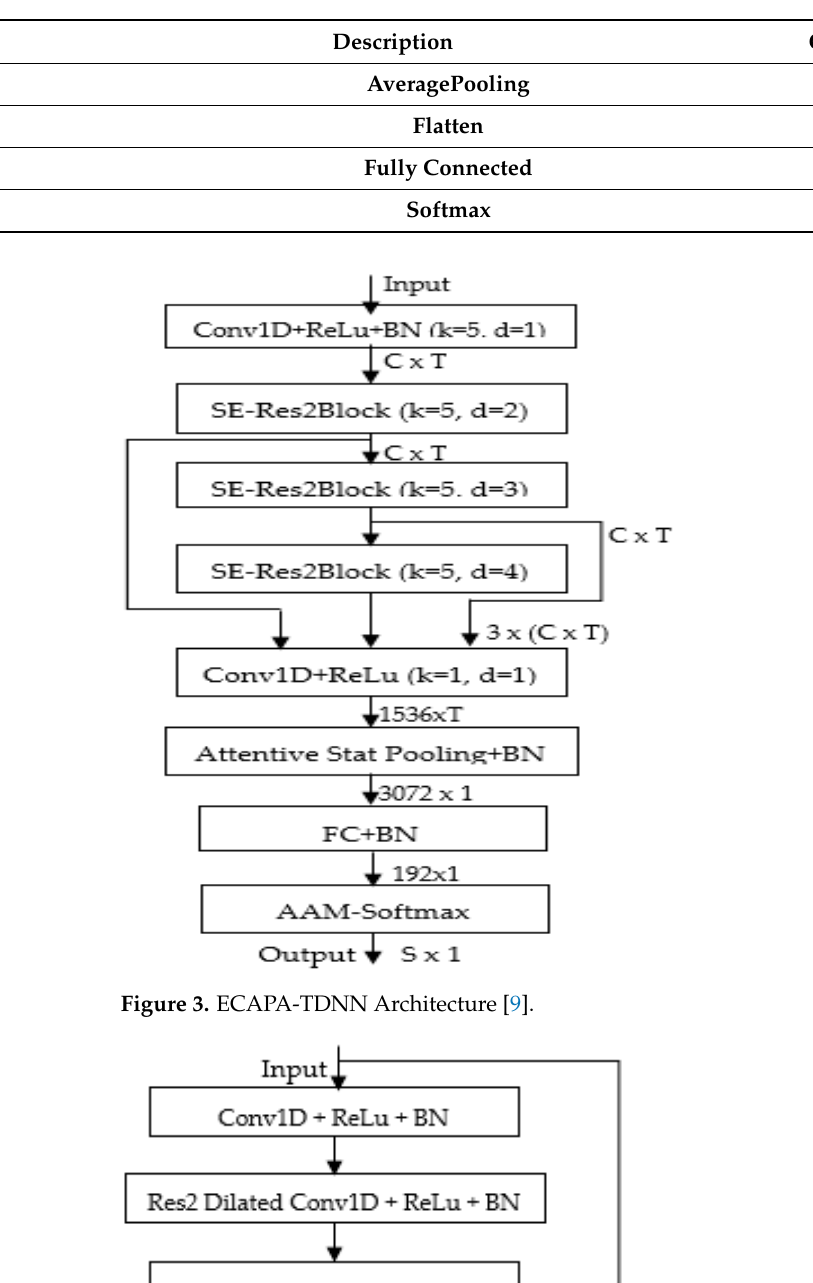
Figure 5. TitaNet Architecture [10].